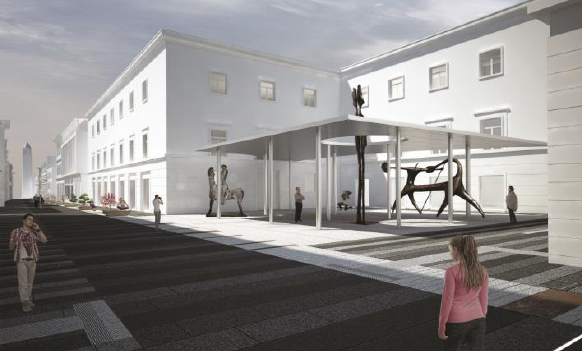
Figure 1. Rendering view of the steel canopy in Teramo (Courtesy of Giustino Vallese and Dario